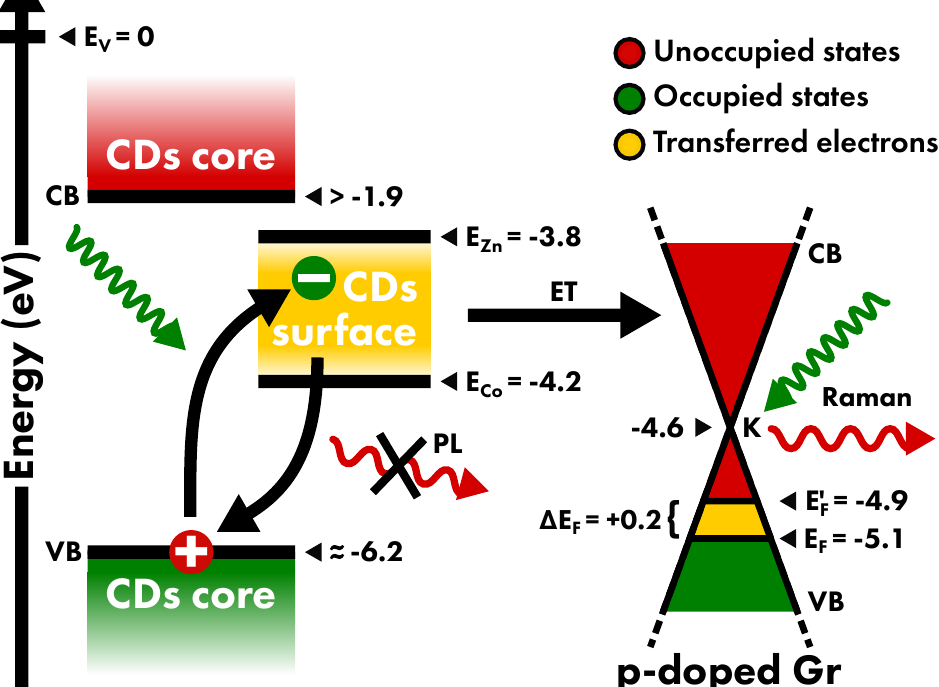
Figure 7. Energy levels scheme of CD core electronic bands, CD surface states, and of Gr electronic bands at K point (Dirac cones) relative to the energy of the vacuum level. The elements of the CDs-Gr interaction described in the proposed model are reported. The laser light (green arrows) is absorbed by CDs and scattered by Gr, thus generating CD PL and Gr Raman signals (red arrows), respectively. In CDs, electrons are promoted from the core valence band (VB) to surface states, for which the energy distribution is between the energies of zinc and cobalt ions. The electron migrates from the surface states towards the conduction band (CB) of Gr by electron transfer (ET). Finally, after an ultrafast relaxation towards lower energy states, the states in the VB of Gr are populated, as attested by the increase of Fermi energy revealed by Raman